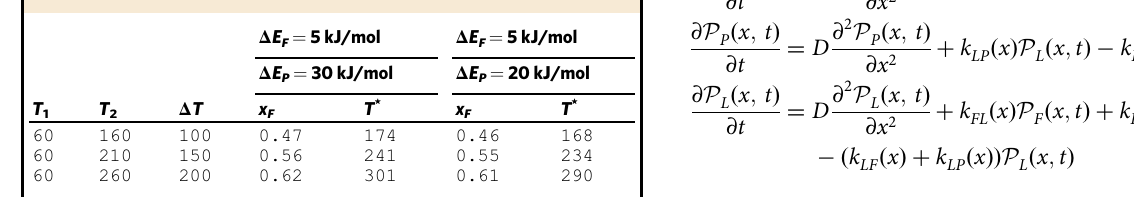
Table 2 Temperature T * required to obtain a given overall molar fraction of furanose, x F , at equilibrium, compared to different choices of gradients that yield the same populations in a non-equilibrium steady state.